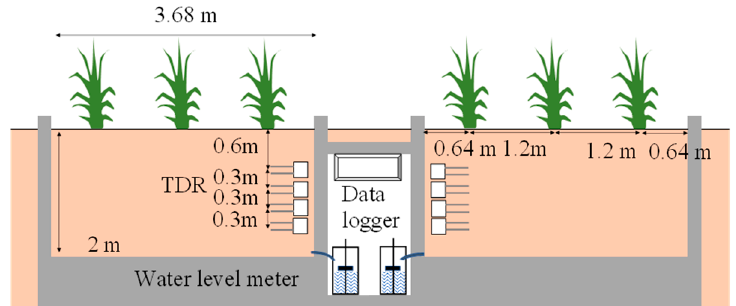
Figure 3. Outline of observations of soil moisture and drainage